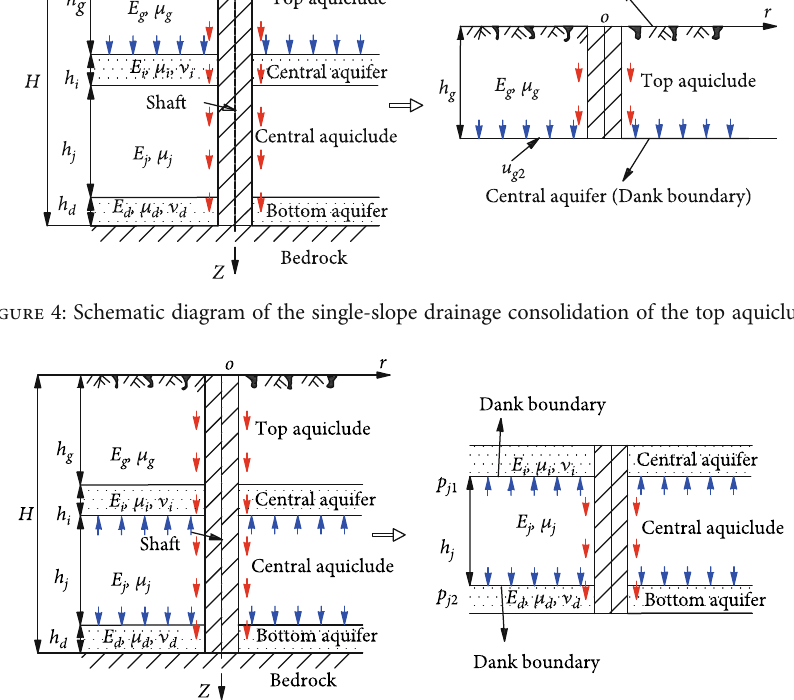
Figure 5: Schematic diagram of the double-slope drainage consolidation of the central